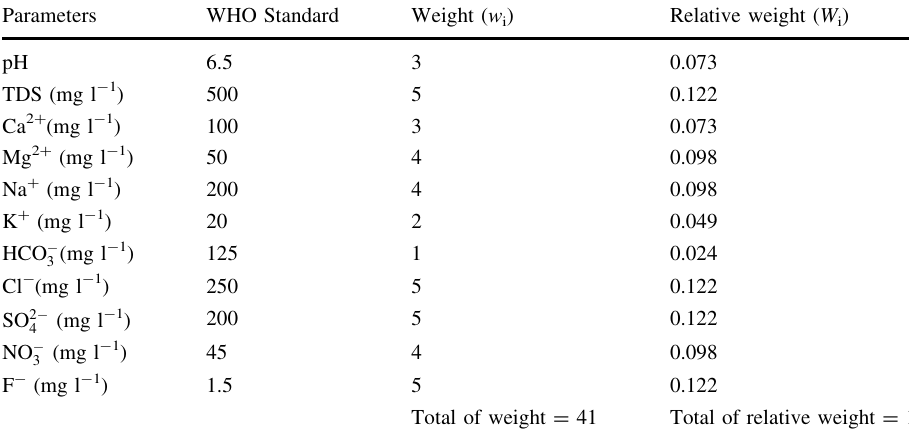
Table 3 Relative weight of chemical